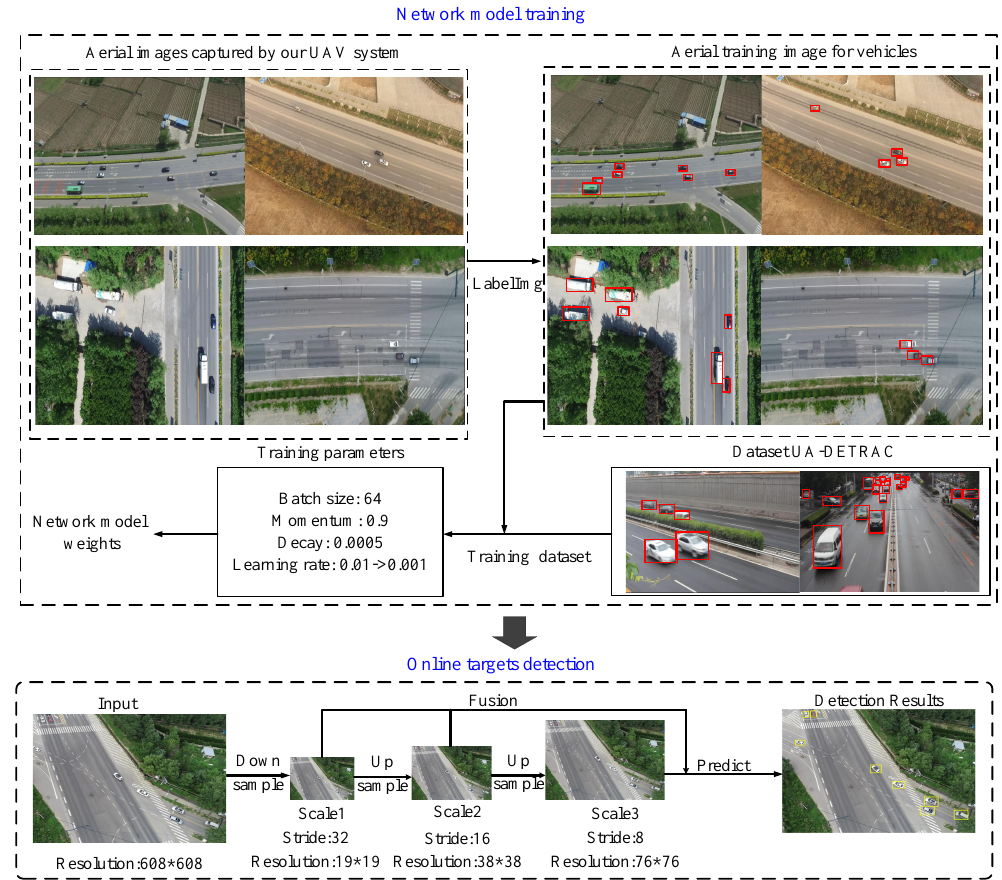
Figure 3. Target-detection process, including offline network-model training and online target detection. In network-model training, the original aerial image was labeled by labelImage, and a training dataset for vehicle target was established. Based on this dataset, we chose a YOLOv3 network model for training. In online target detection, we can obtain a series of target-detection bounding boxes by using training network-model